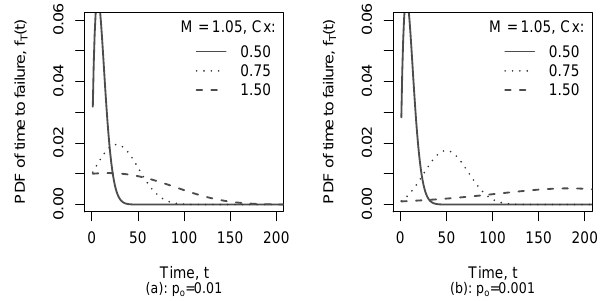
Figure 5. PDF of the time to failure distribution for the nonstation- ary GP2 model, with a fixed M = 1.05 for a range of trend values ( C x = 0.5, 0.75, 1.50); panels show three exceedance event sizes increasing in extremity: (a) p o = 0.01 and (b) p o =